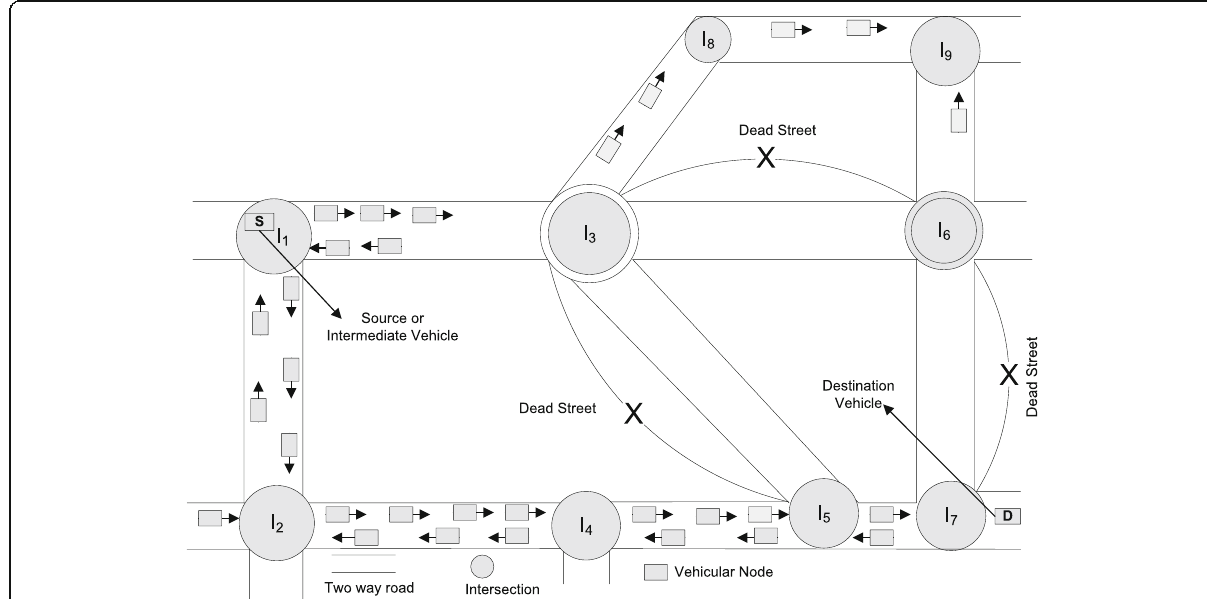
Fig. 3 Working of RPSPF protocol. Each circle represents a junction. Double lines represent bidirectional two-lane roads, and the small rectangular box with arrow represents vehicular node moving in the direction of the arrow, S represents source vehicle, and D indicates the